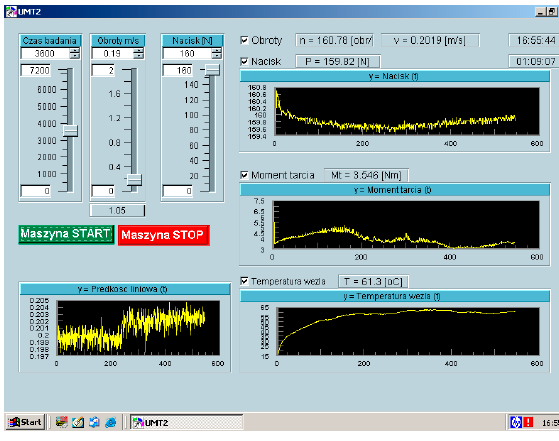
Figure 2. UMT 2169 friction wear machine.